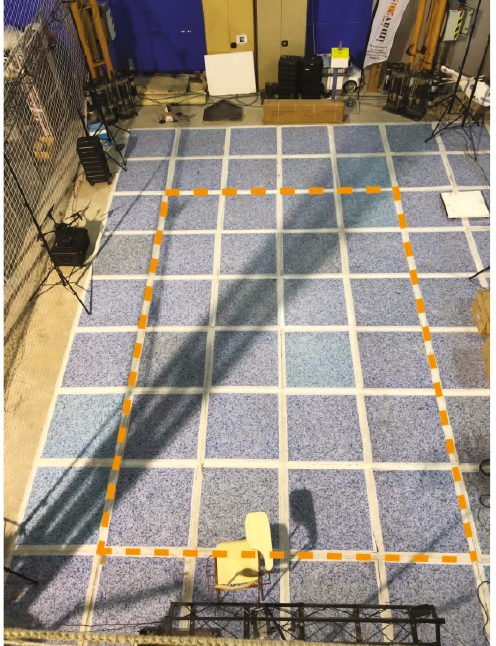
Figure 14. Indoor tests scenario 2.